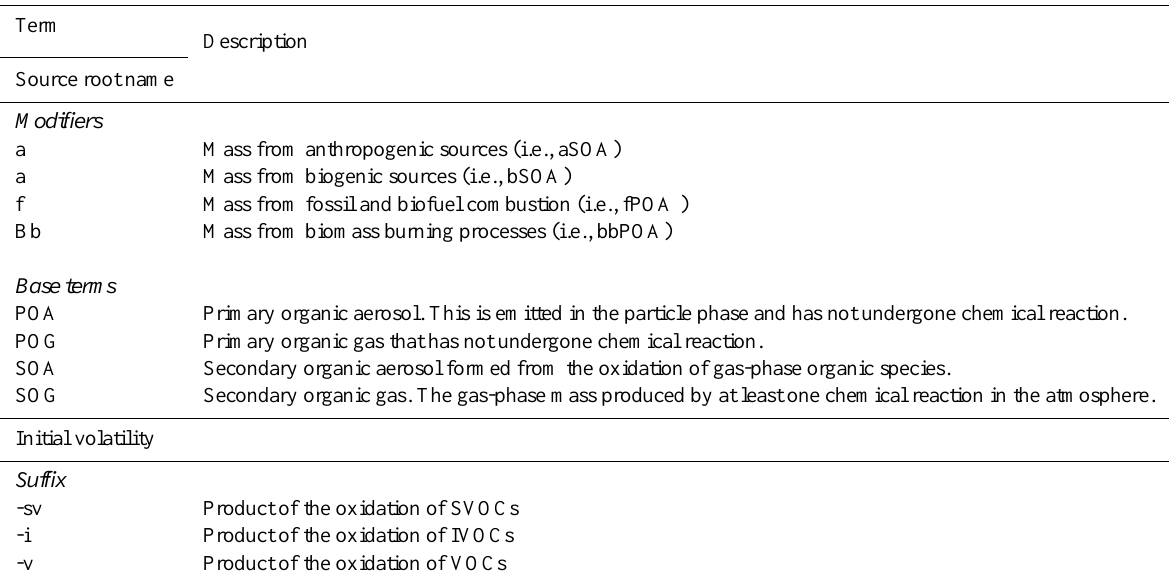
Table 1. Organic component name classifications in the ORACLE